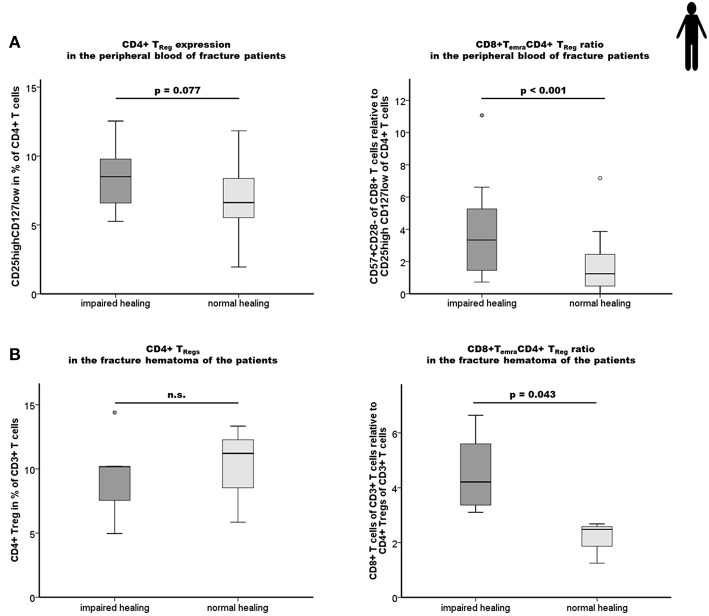
Impaired fracture healing correlates with an elevated level of CD4+ TReg and a higher ratio of CD8+ TEMRA/CD4+ TReg. (A) Results of the flow cytometry analyses of the CD4+ TReg and the ratio CD8+TEMRA/CD4+TReg in the peripheral blood of fracture patients at the time of operation are shown. Impaired fracture healing patients showed slightly elevated levels of CD45+CD3+CD4+CD25highCD127low TReg (CD25highCD127low in % of CD45+CD3+CD4+) compared to the normal healing patients indicates a partial, but not sufficient compensatory effect. The ratio of CD8+TEMRA/CD4+TReg was significantly higher in patients with a delayed healing: n = 12 for the impaired healing group, n = 23 for the normal healing group. (B) Impaired fracture healing patients showed a significantly higher ratio of CD8+T cells/CD4+ TReg in the hematoma region demonstrating an insufficient compensatory effect of the CD4+ TReg in the impaired fracture healing patients: n = 5 for the impaired healing group, n = 3 for the normal healing group. Student's t-test.